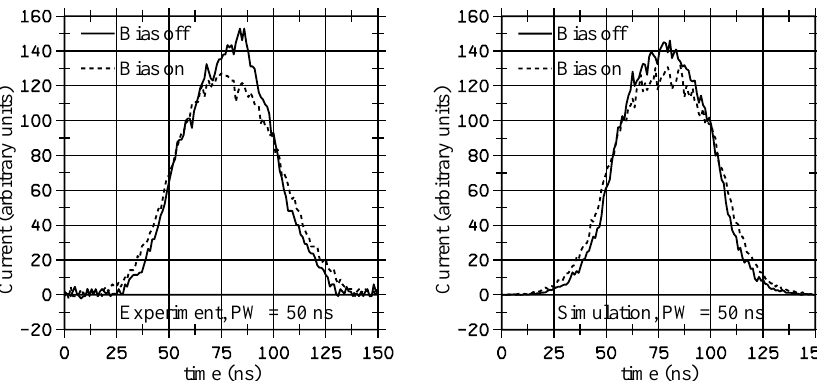
FIG. 3. Measured (left) and simulated (right) pulse shapes after 625 m s for an injected pattern width of 50 ns. The simulations used 4 3 10 12 protons. Solid curves represent the shape with no bias on the inductor ( 7.29 m H in the simulation). Dotted curves represent the shapes with a 900 A bias applied to the inductor ( 2.49 m H in the simulation). Buncher voltage was 7.5 kV.